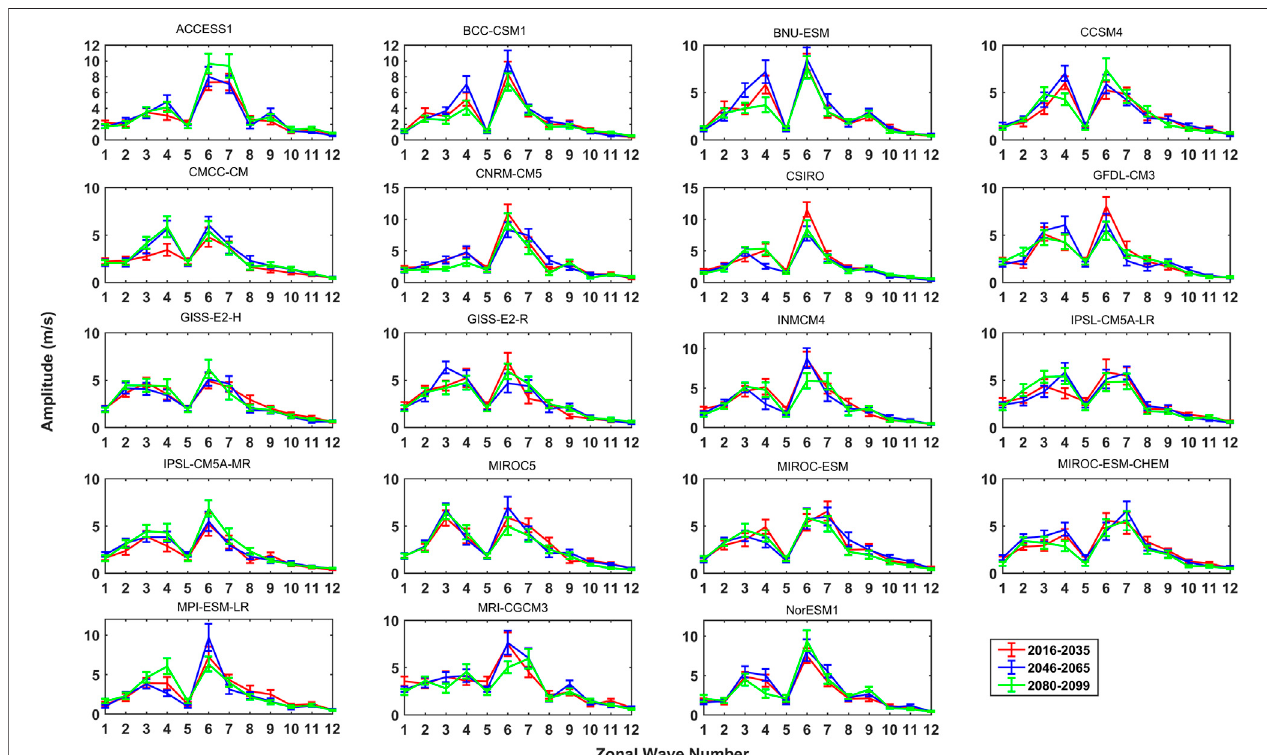
FIGURE 6 | Zonal wave number spectra for the meridional wind fi elds at 300 hPa over 37.5 ° to 57.5 ° N for the June month for the near, mid and far future terms under RCP4.5 scenario.